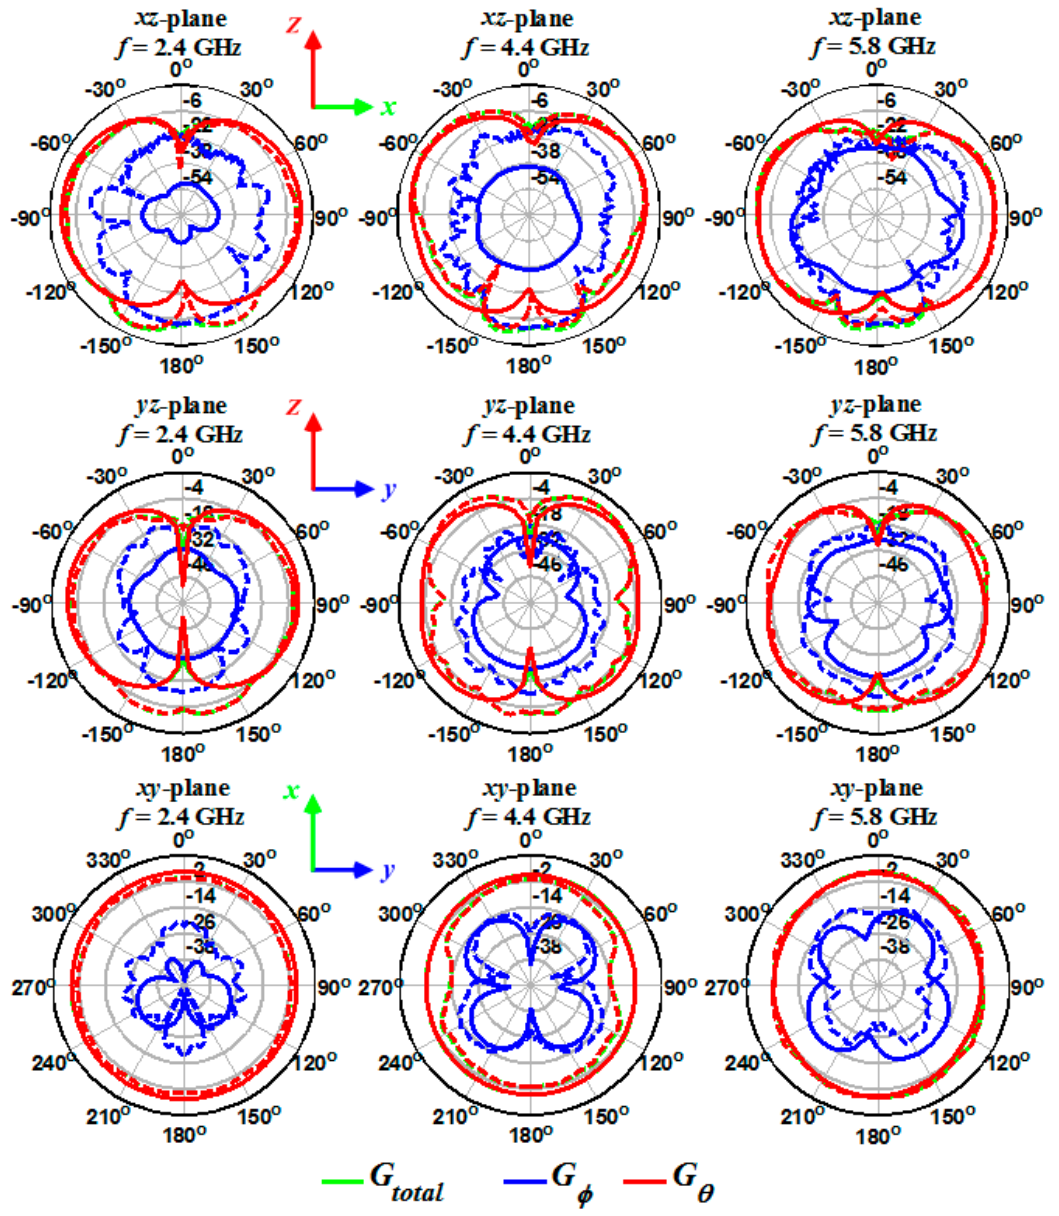
Figure 19. Measured (dashed lines) and simulated (solid lines) gain for the single-port antenna on three different planes and frequencies.